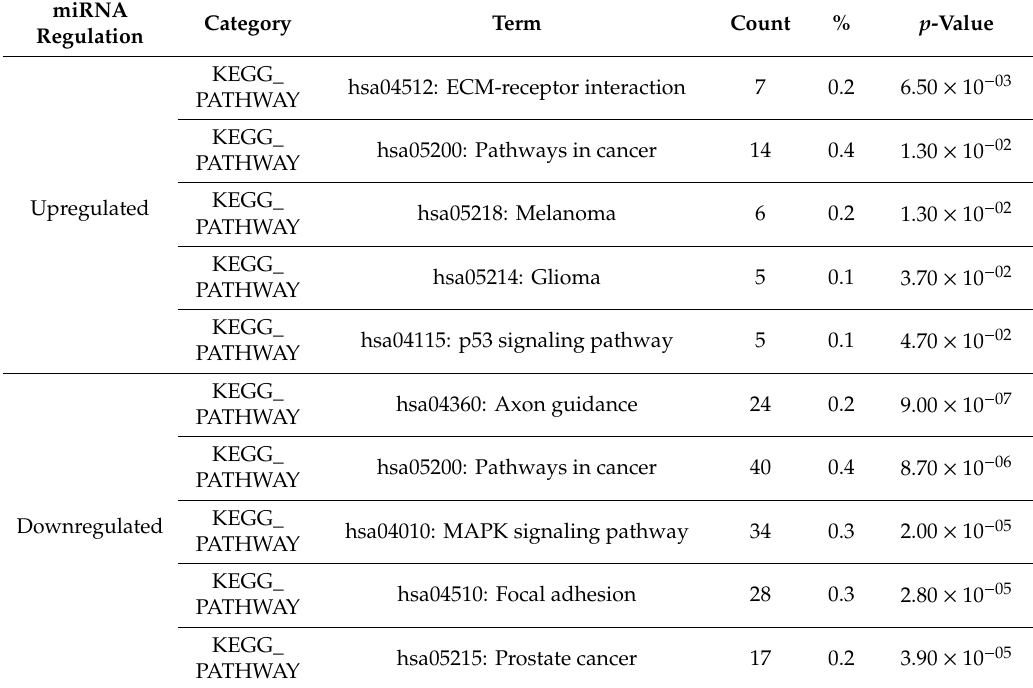
Table 4. Kyoto Encyclopedia of Genes and Genomes (KEGG) enrichment pathway analysis of DEGs of dysregulated